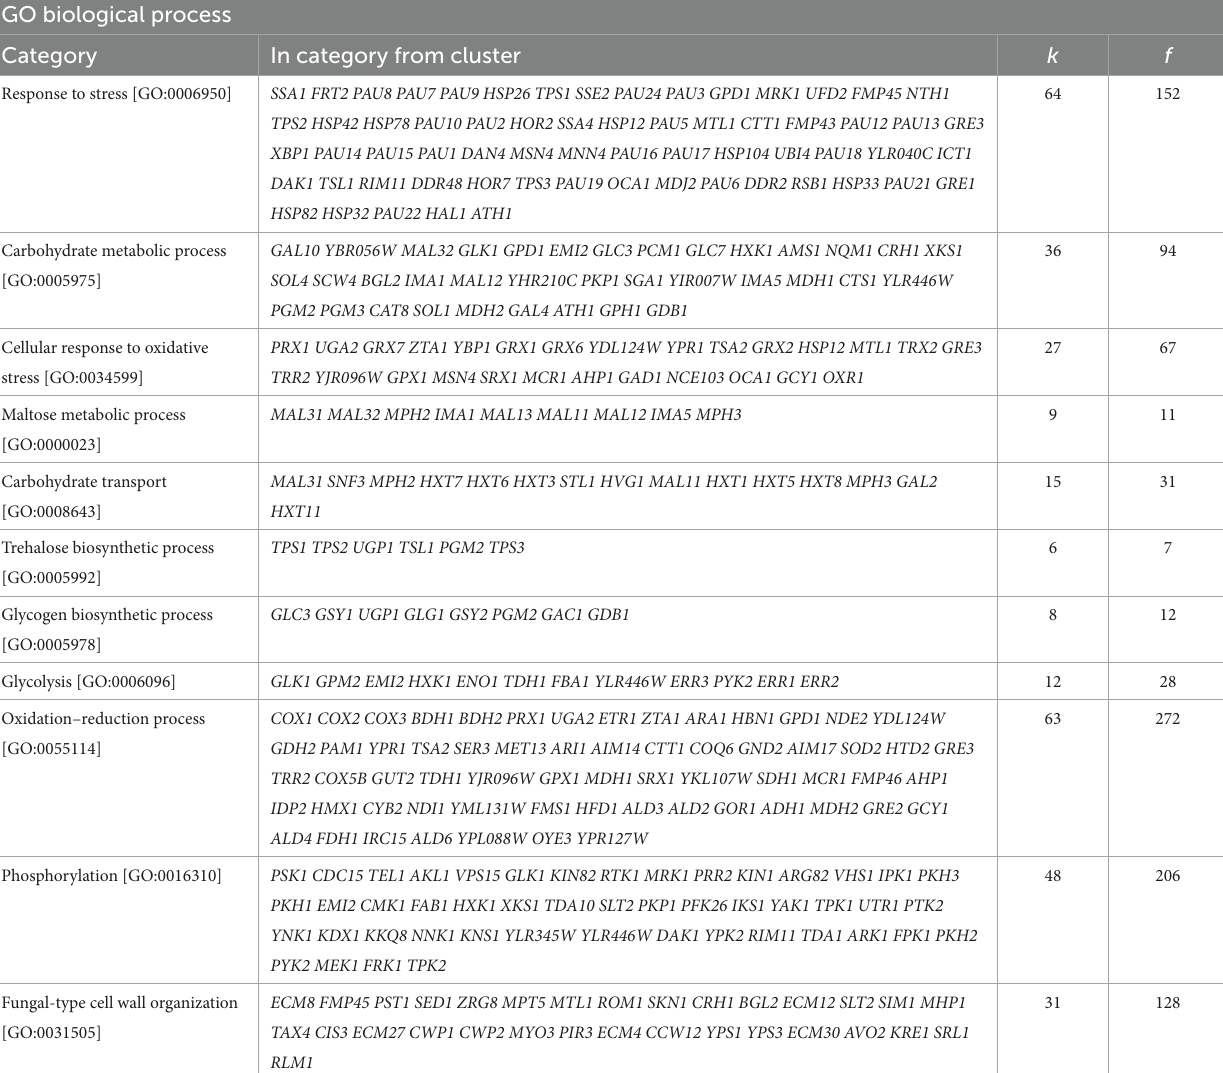
TABLE 2 FUNSpec Gene Ontology (GO) analysis results of the upregulated genes in C9 ( k : number of genes in input cluster in given category, f : total number of genes in given category). GO biological process